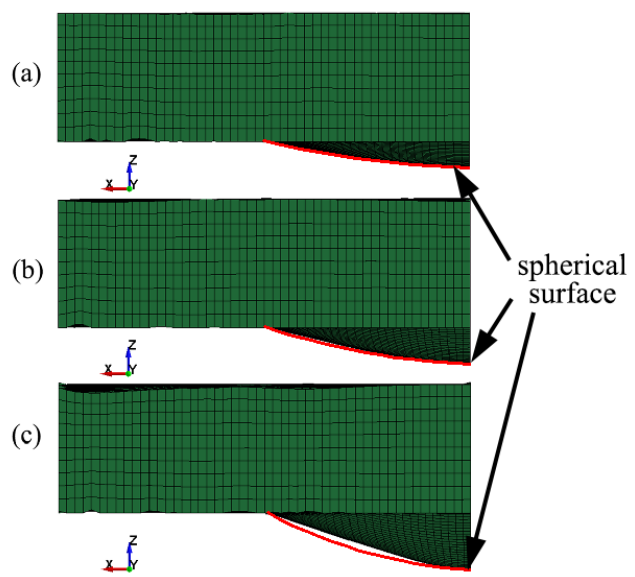
Figure 6. Deformation shape of silicone rubber under different conditions in the numerical simulation: